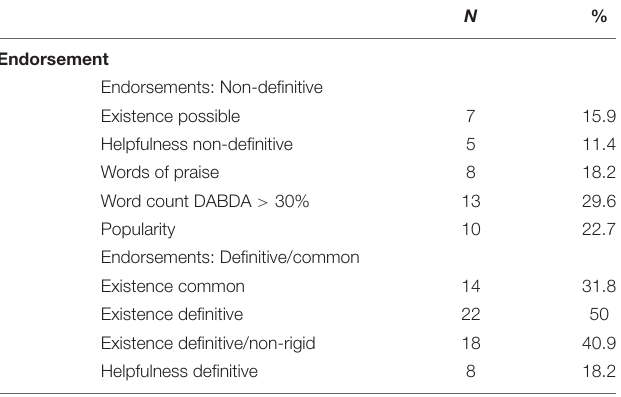
TABLE 4 | Frequencies and percentages of endorsements of five stages model.